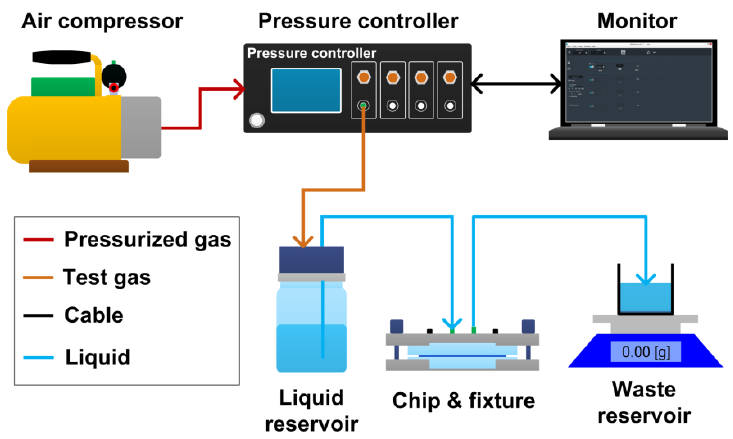
Figure 4. Schematic experimental setup for measuring the flow rate of the microfluidic flow regulatory device.